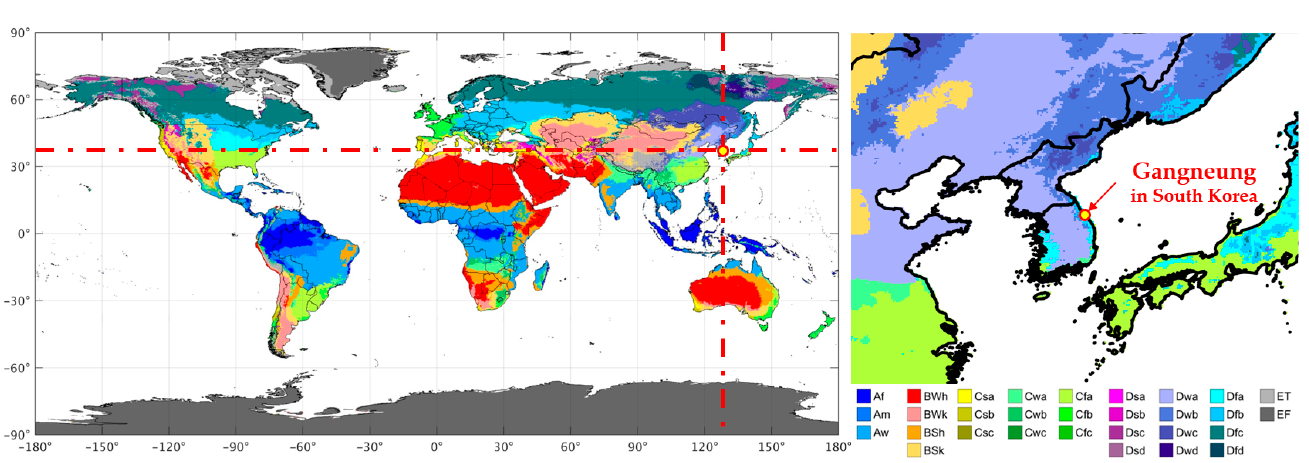
Figure 4. Location and climate classification of Gangneung in the Koppen–Geiger climate classifica- tion map [29].